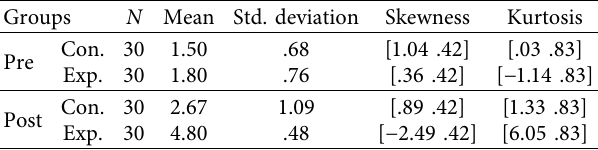
Table 3: Descriptive statistics for both groups in two time points.